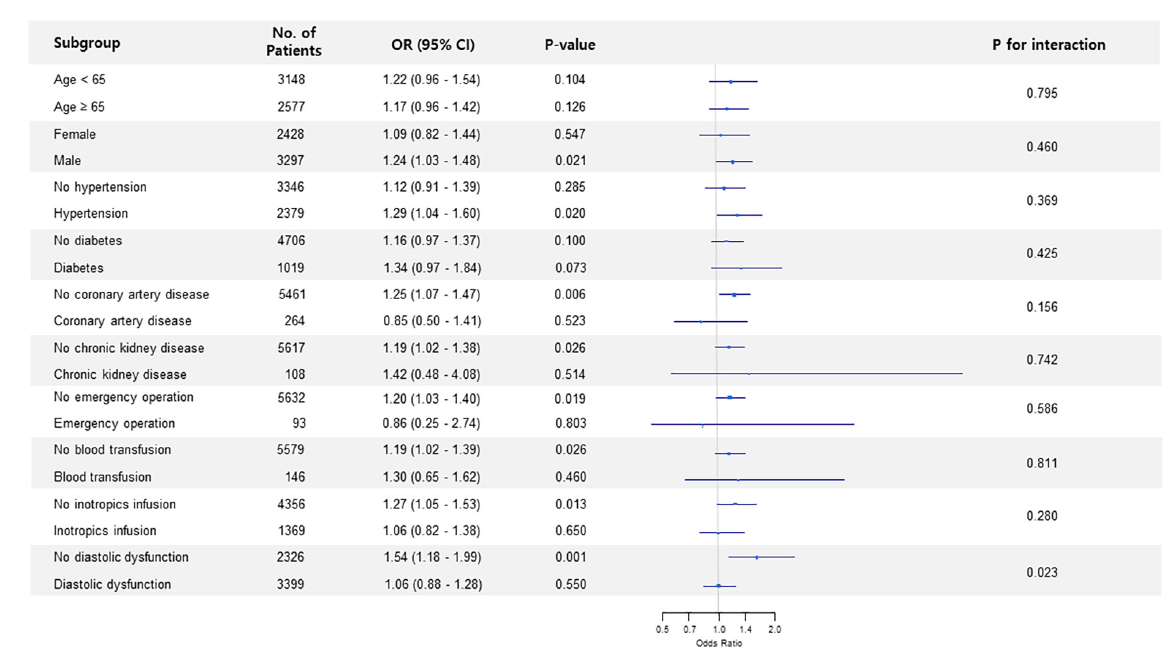
FIGURE2 Forest plot of subgroup analysis in thoracic surgery.